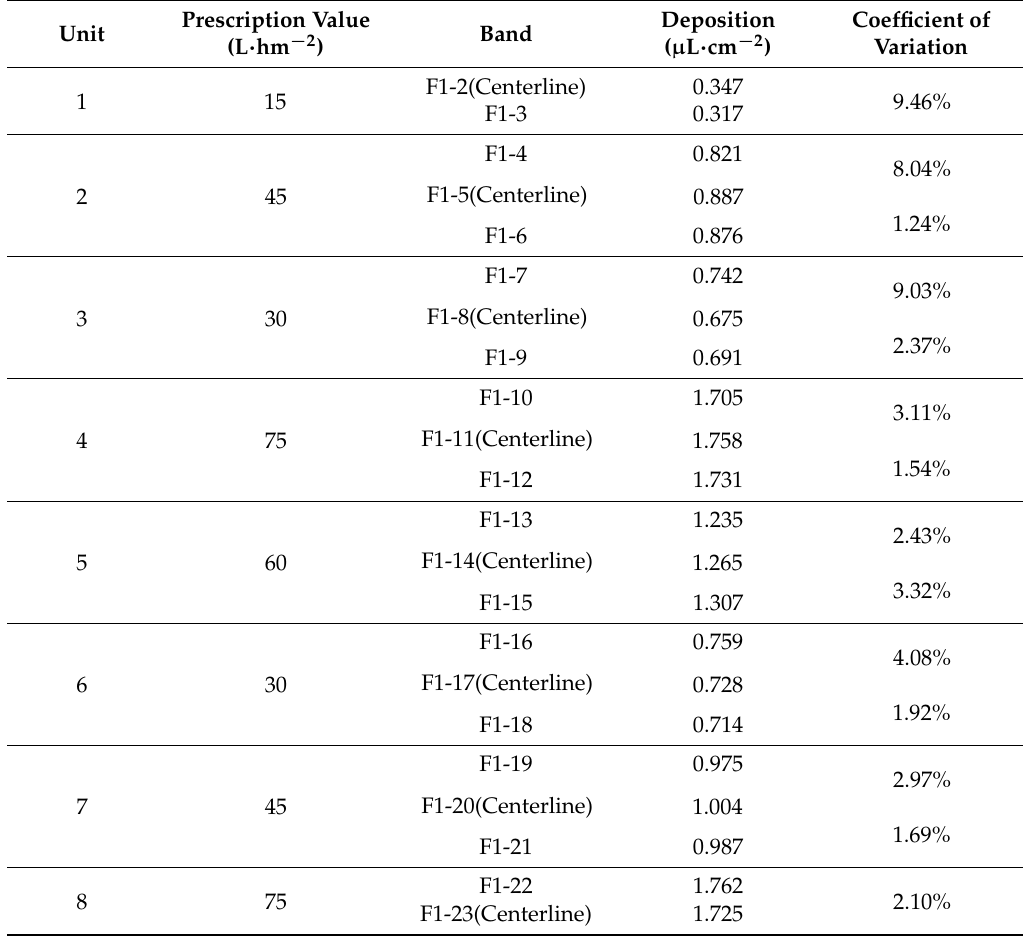
Table 5. The amount of droplet deposition in three units of operation route